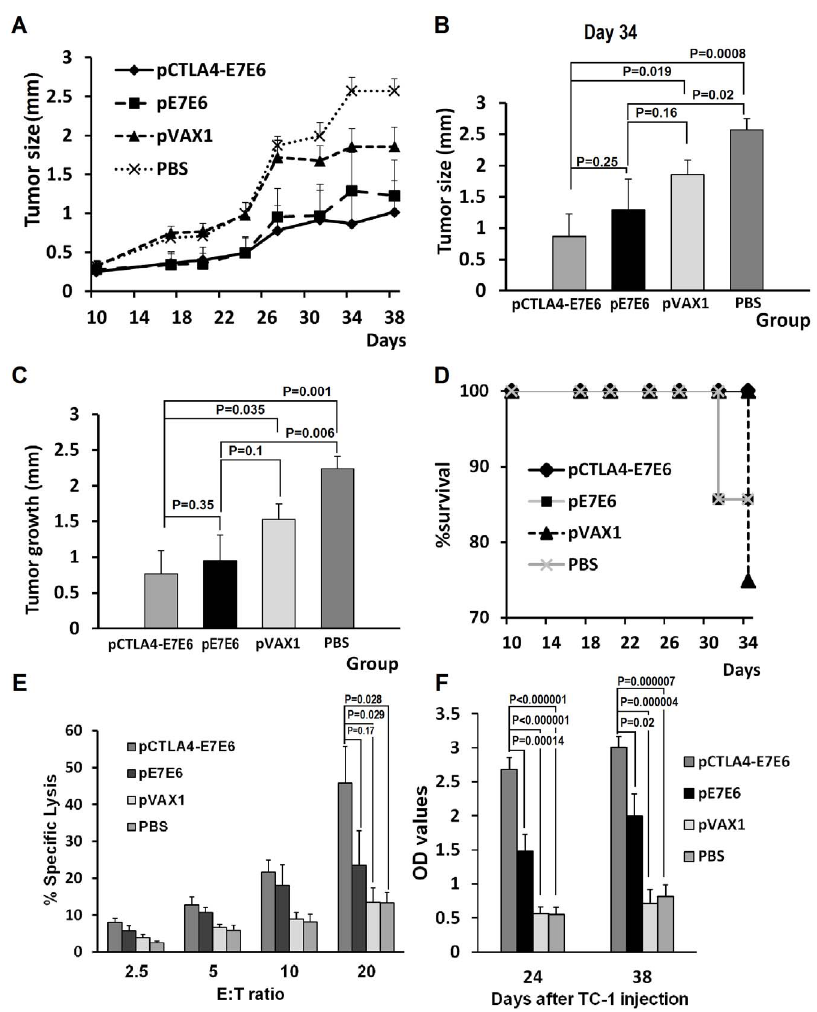
Figure 4. Anti-tumor therapeutic efficacy of pCTLA4-E7E6. ( A ) Effects on tumor growth by therapeutic vaccination. Tumor-carrier mice were vaccinated with pCTLA4-E7E6, pE7E6, pVAX1 or PBS twice on day 10 and 17 after TC-1 cells injection. Tumor size was recorded twice or thrice a week. ( B ) Statistic analysis of tumor sizes on day 34 among groups. The graph shows means 6 SE. ( C ) Statistic analysis of tumor development between day 10 and day 38 among groups. ( D ) Kaplan-Meier survival analysis of mice survival in different groups. ( E ) Tumor specific CTL responses. Spleen cells were collected from alive mice in different groups on day 38 and used as effector (E) cells. TC-1 cells were used as target (T) cells. The cellular immune response against E7E6 was determined by lactate dehydrogenase (LDH) release assay. Various E/T ratios were tested as indicated. The data were presented as means 6 SE. ( F ) The levels of specific anti-E7E6 serum IgG were determined by ELISA assay on day 24 and 38. The antibody levels of each group were presented as mean OD values 6 SE. pE7E6 without statistical significance ( P =0.132, E:T= 20:1) (Figure 5C). The two DNA vaccination groups showed signifi- cantly stronger CTL responses than the control groups ( P , 0.05).